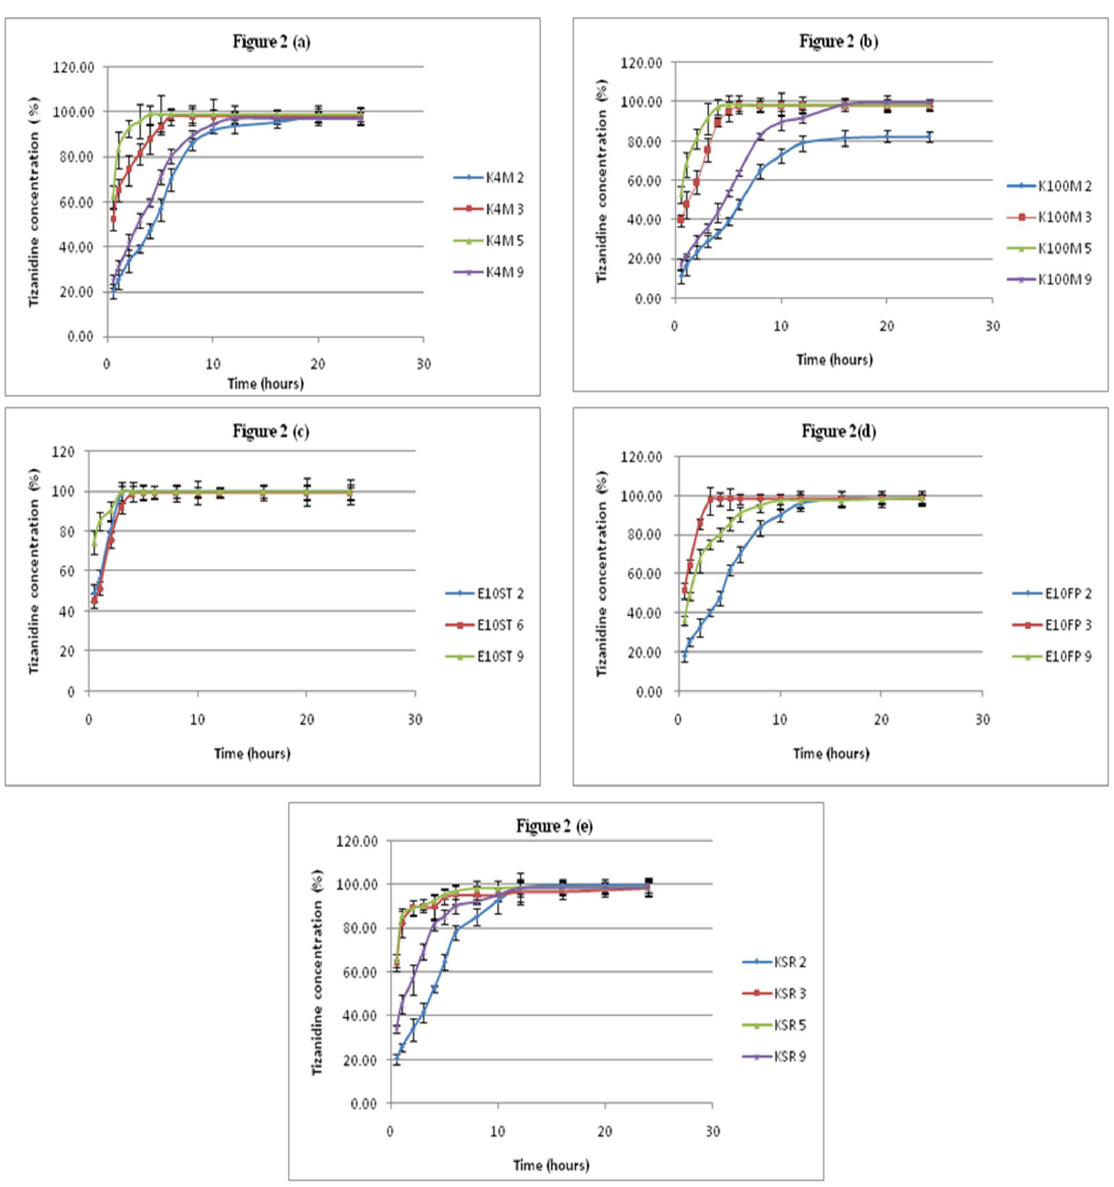
FIGURE 2 - Drug release profiles of Tizanidine formulations in 0.1 N HCl containing (a) HPMC K4M (b) HPMC K100M (c) Ethocel 10ST (d) Ethocel 10FP (e) Kollidon